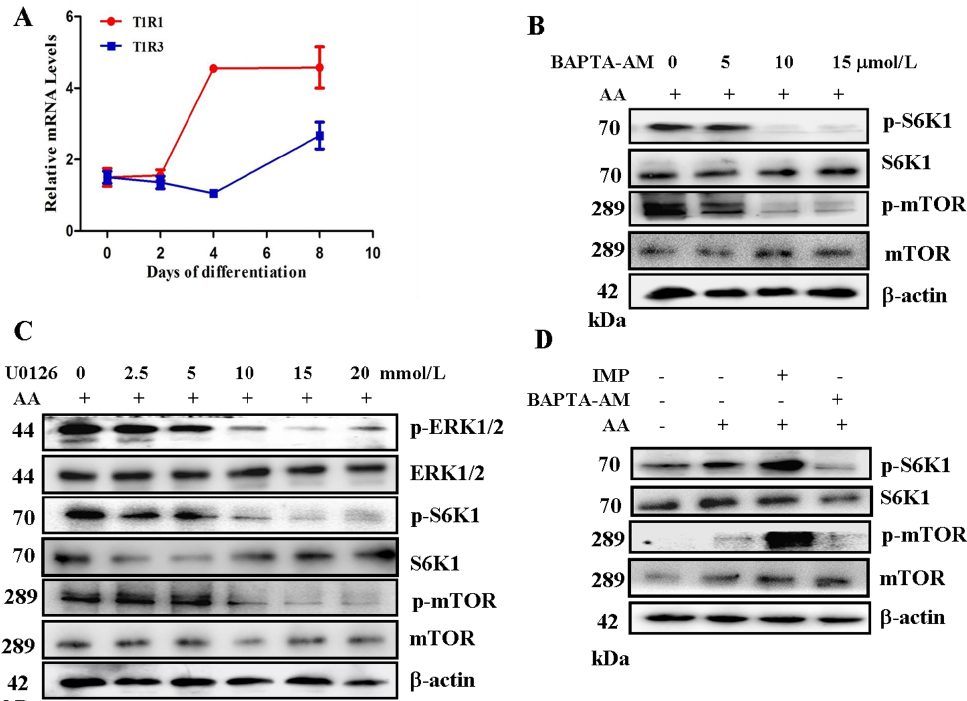
Figure 1. T1R1/T1R3-mediated amino acids regulate ERK1/2 and mTORC1 through stimulation of Ca 2+ in C2C12 myotubes. RNA was isolated from C2C12 myoblasts of different differentiation times for quantitative polymerase chain reaction (Q-PCR) analysis ( A ); Serum-starved C2C12 cells in Krebs-Ringer’s solution (KRBH) were treated with the indicated concentrations of BAPTA-AM 15 min prior to treatment with AA for 60 min, p-S6K1, p-mTOR protein levels were analyzed by Western blotting, and β -actin was used as a loading control ( B ); C2C12 myoblasts in KRBH were treated with the indicated concentrations of U0126 15 min prior to treatment with AA for 60 min. Immunoblots were performed with the indicated antibodies ( C ); C2C12 cells in KRBH were treated with the 1 mM/L IMP or 10 µ M/L BAPTA-AM 15 min prior to treatment with AA for 60 min. Immunoblots were performed with the indicated antibodies ( D ). “+” means to add, “-” means not to